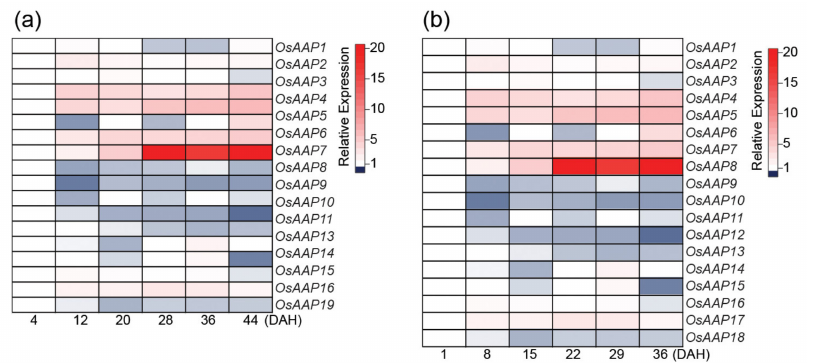
Figure 2. Heat map of the expression of the rice AAPs (amino acid permease, OsAAPs ) during leaf senescence. Expression data were from RNA-seq analysis ( a ) [20] and microarray data ( b ) [21]. Gene nomenclature of each gene was followed in the previous report [120]. Relative expression levels were quantified as describes in Figure